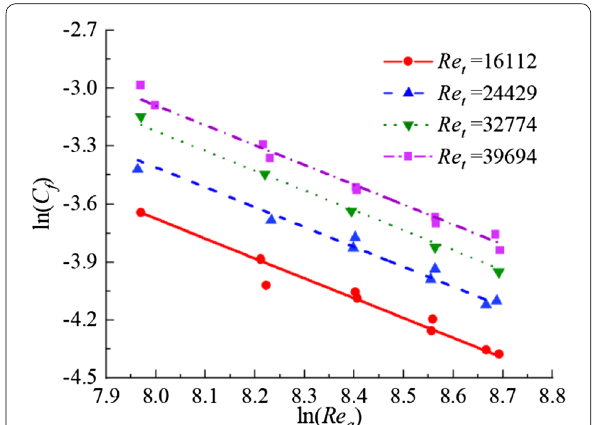
Figure 11 Logarithmic results of the experimental data and